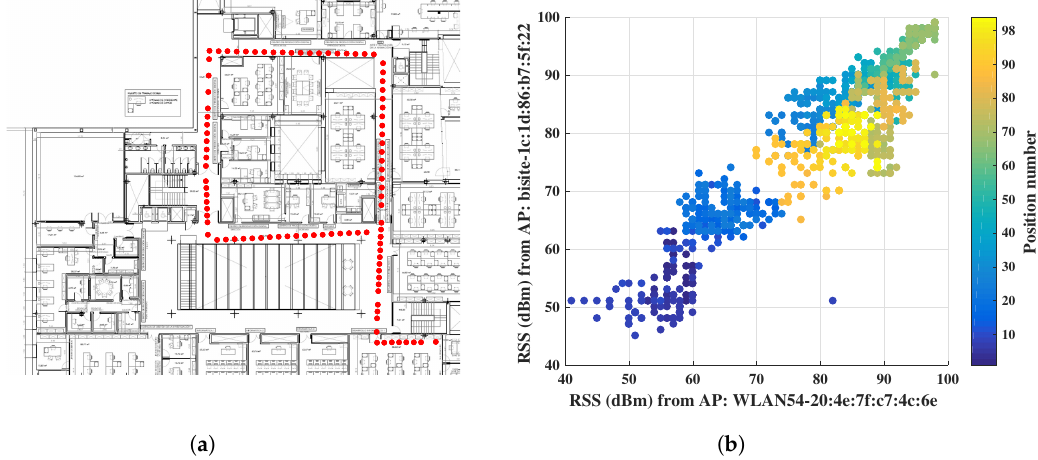
Figure 3. Actual online path obtained from RSS values and their distribution in 2D plane: ( a ) the actual online trajectory; and ( b ) the dots with the same colors are received RSS values at the same position.